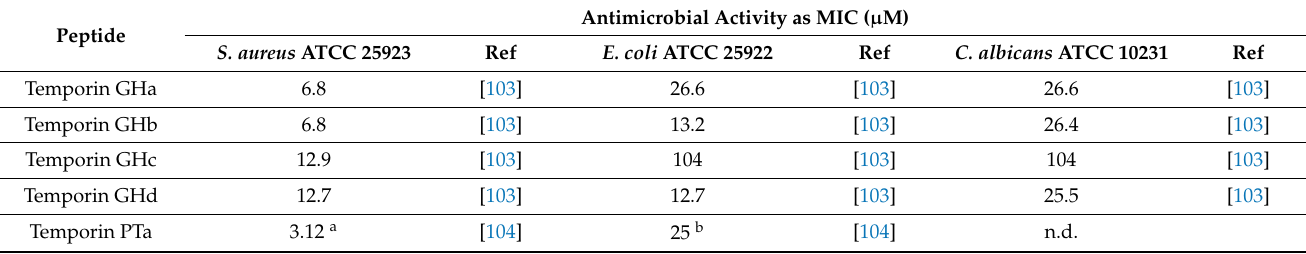
Table 7. Antimicrobial activity against selected microorganisms of peptides from Hylarana . Antimicrobial Activity as MIC ( µ Peptide